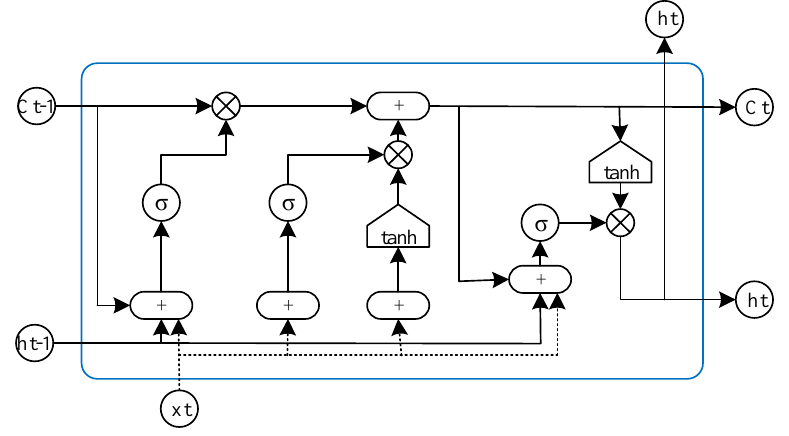
Figure 6. Long short-term memory ( LSTM) basic unit logic architecture.